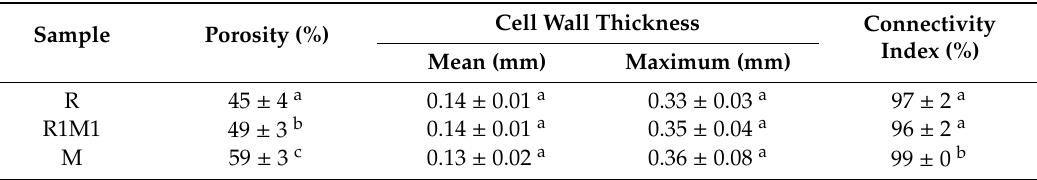
Figure 4. Cross-sectional 2D X-ray micro tomography images of printed single-layer samples after baking. The images represent the area of the sample where the hardness measurement by cutting was performed. Table 3. Microstructural properties of single-layer printed samples after baking based on analysis of 3D X-ray micro tomography images.